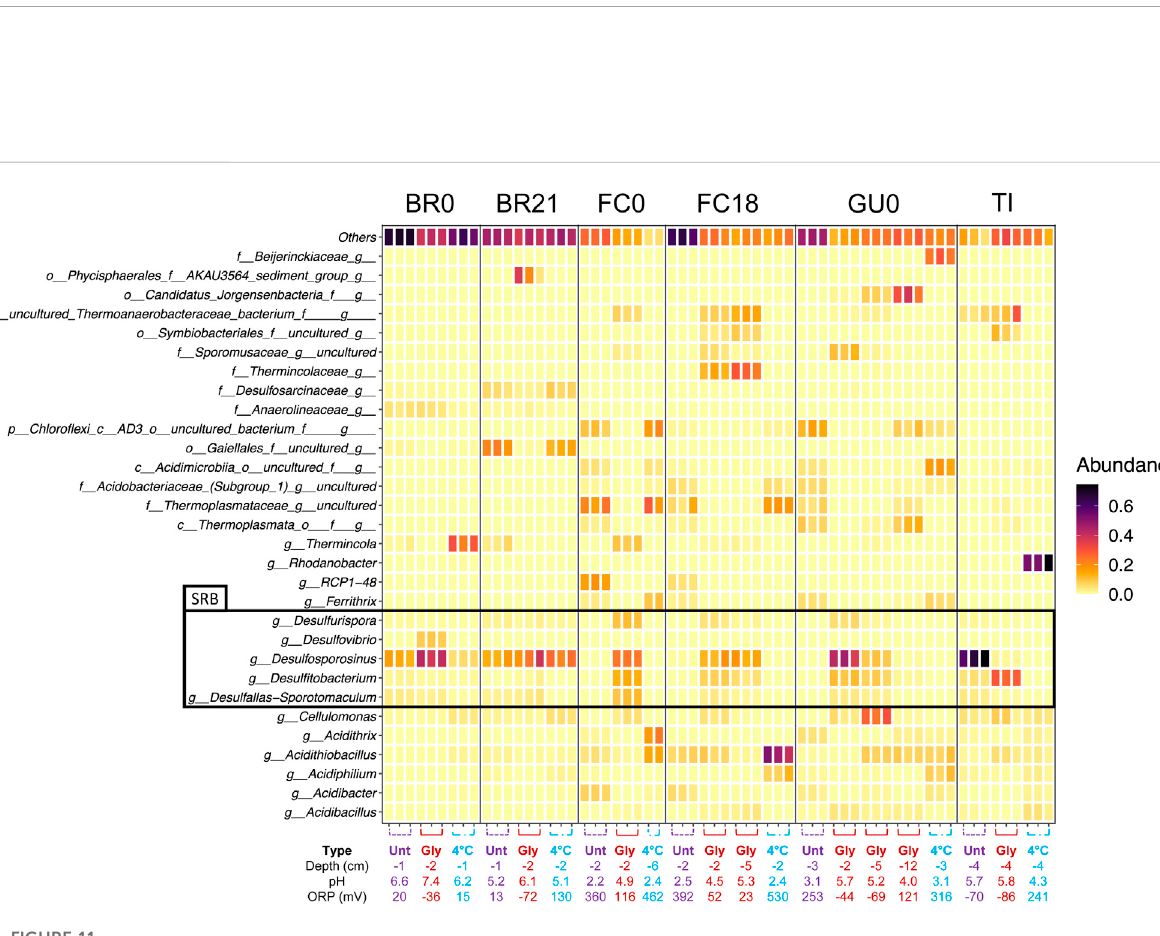
Frontiers in Bioengineering and